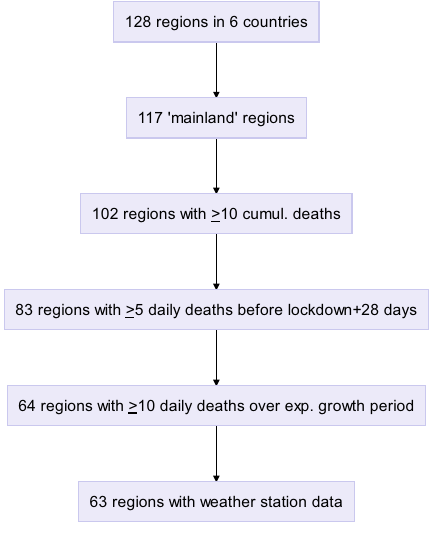
Figure 1. Study flow chart.